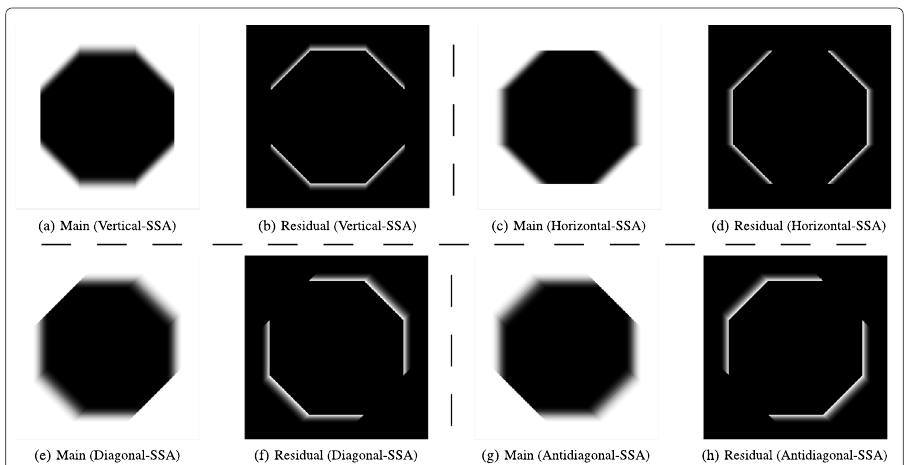
Fig. 6 These main and residualcomponents show the “Octagon” image processed with “ SSA-iSBD2-channel filterbank ” with following types of “ chosen-SSA ”: “ Vertical-SSA ,” “ Horizontal-SSA ,” “ Diagonal-SSA , ”and “ Antidiagonal-SSA